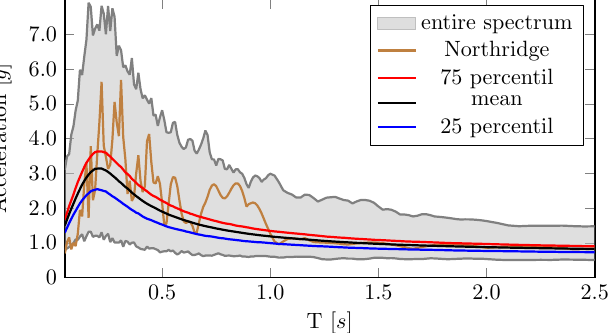
Figure 4. Acceleration response spectra of all generated earthquakes using the presented procedure. The mean, 25 percentile, and 75 percentile spectrum are compared with the spectrum of the benchmark earthquake (Northridge